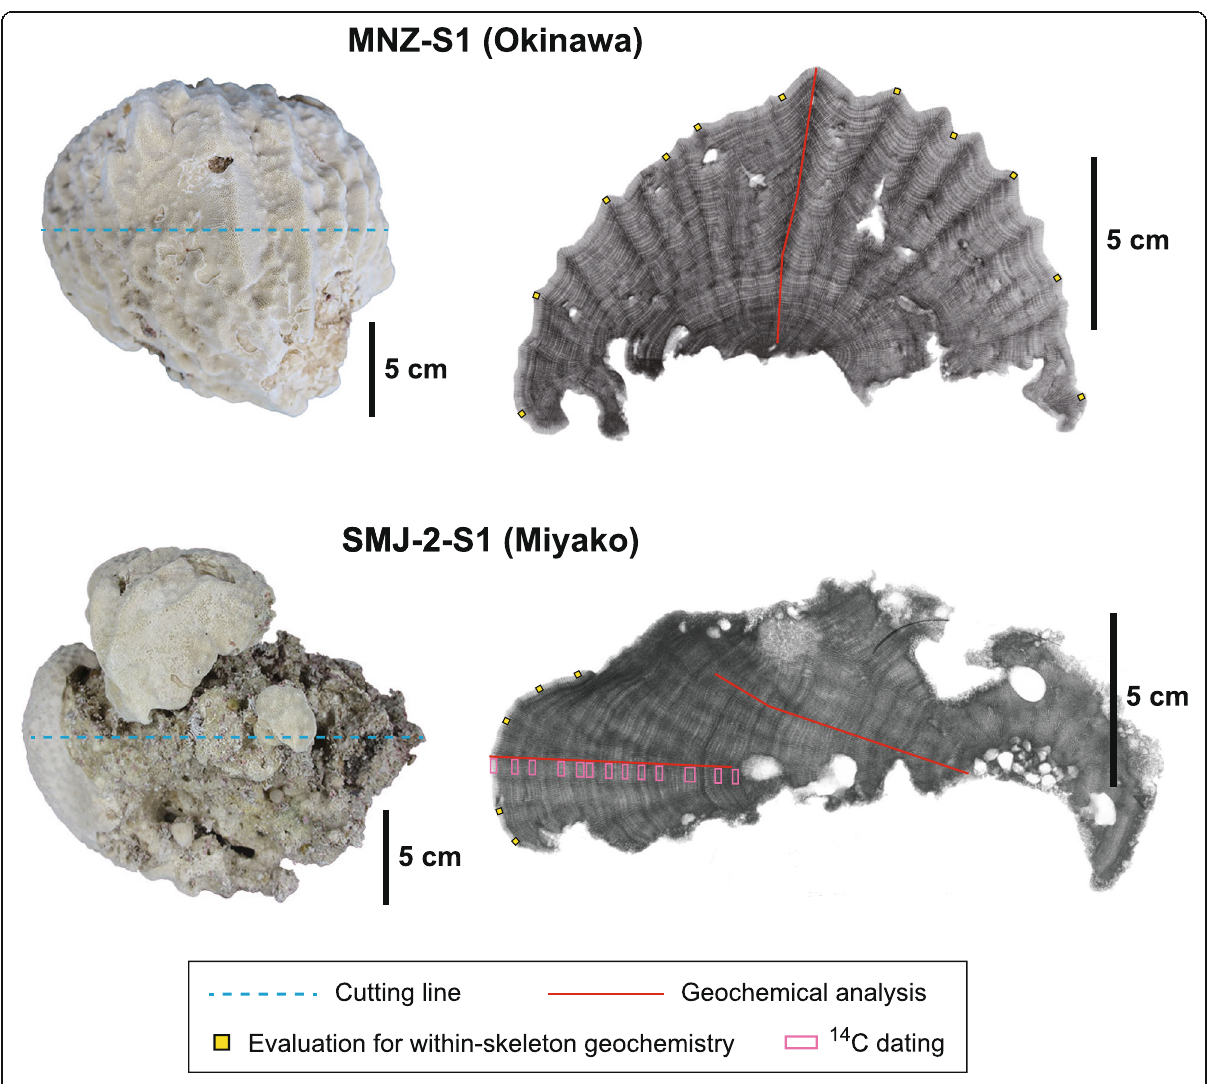
Fig. 2 Photos and X-radiographic positive images of the two modern sclerosponges show skeletal growth bandings comprising alternating high- density (dark) and low-density (light) bands. Slab samples were extracted by cutting along the blue lines. Geochemical analyses were conducted along sampling transects for generating the time series (red lines) and at selected portions of the coeval skeleton for evaluating within-skeleton variation (yellow squares). Radiocarbon measurements were taken at selected skeletal portions (pink